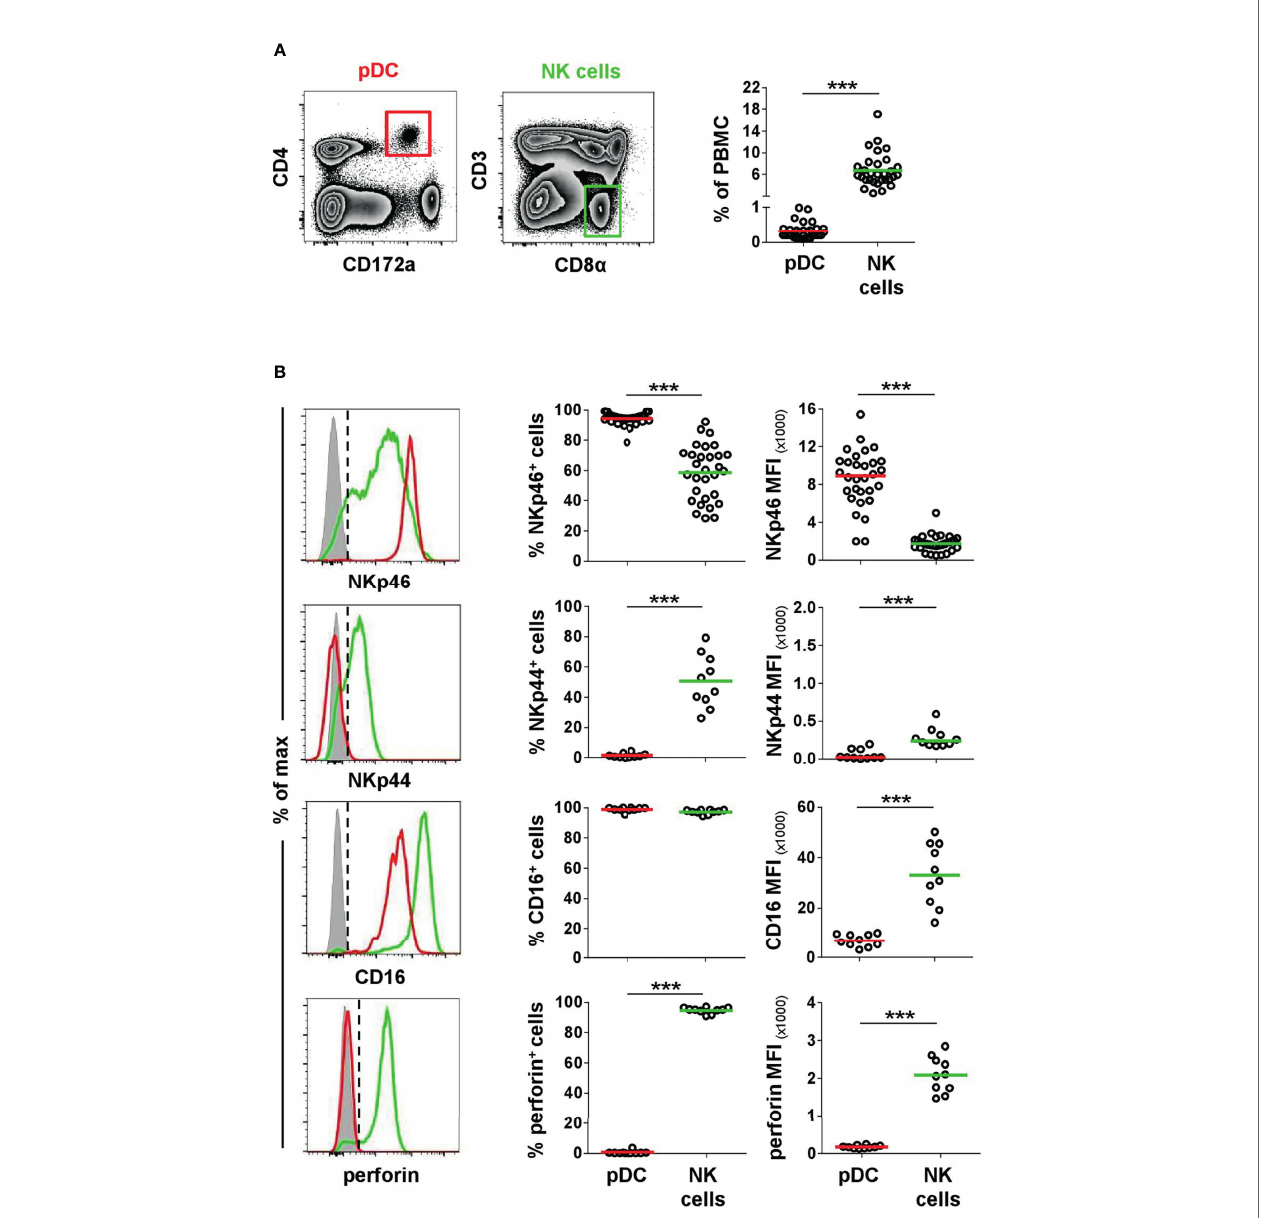
FIGURE 2 | Co-expression of NK-associated markers on porcine pDCs. (A) Frequencies of CD4 high CD172a low pDCs (red gate) and CD3 - CD8 a + NK cells (green gate) were analyzed in blood of 30 animals by FCM. (B) Blood-derived porcine pDCs (red) and NK cells (green) were identi fi ed by phenotypes as in (A) and were analyzed for their expression of the NK-associated surface markers NKp46 ( n = 30 ), NKp44 ( n = 10 ), and CD16 ( n = 10 ) as well as the effector molecule perforin ( n = 10 ) by multicolor FCM. Representative staining patterns of one animal are shown in the histograms on the left; unstained control is shown as tinted gray histogram. Percentages of positive cells were obtained according to unstained controls, indicated by the black dashed line. Graphs show frequencies of NKp46 + , NKp44 + , CD16 + , or perforin + cells (middle column), as well as median fl uorescence intensities (MFI) of the four molecules (right column) within pDCs and NK cells. Mean (frequencies) and median (MFI) values are represented by colored bars. Signi fi cant differences between pDCs and NK cells are indicated (*** p ≤ 0.001